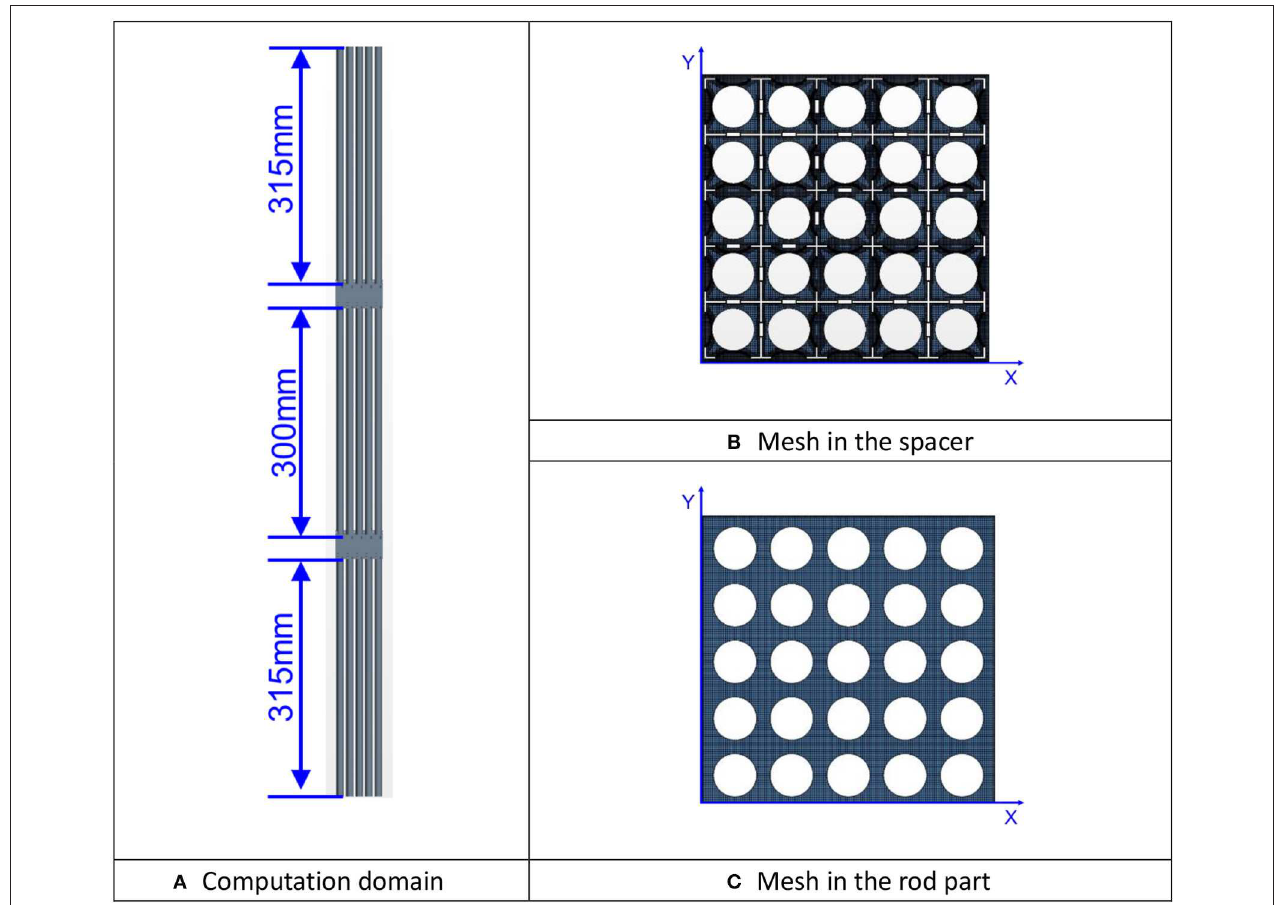
TABLE 1 | Configuration of mesh for sensitivity analysis.